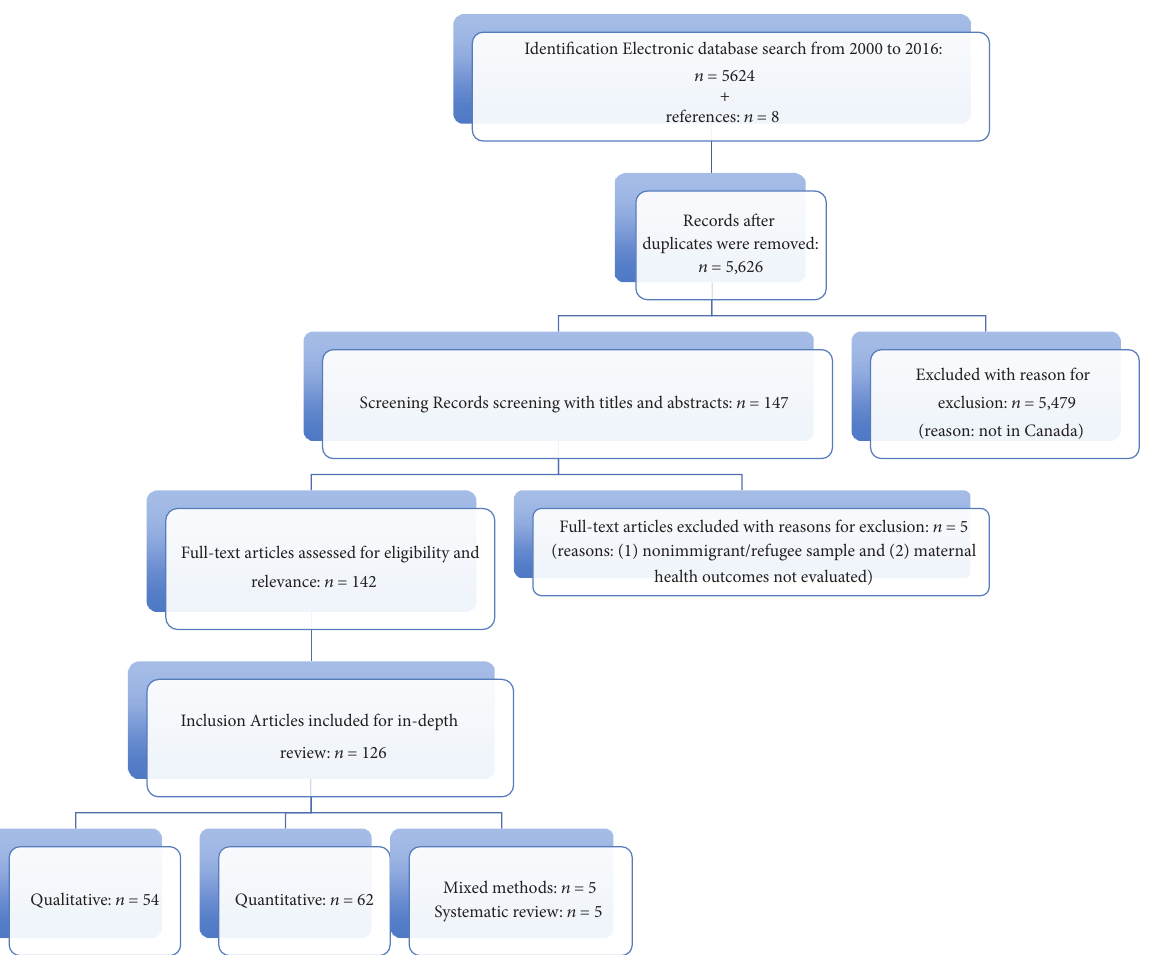
Figure 1: Flowchart illustrating the scoping review